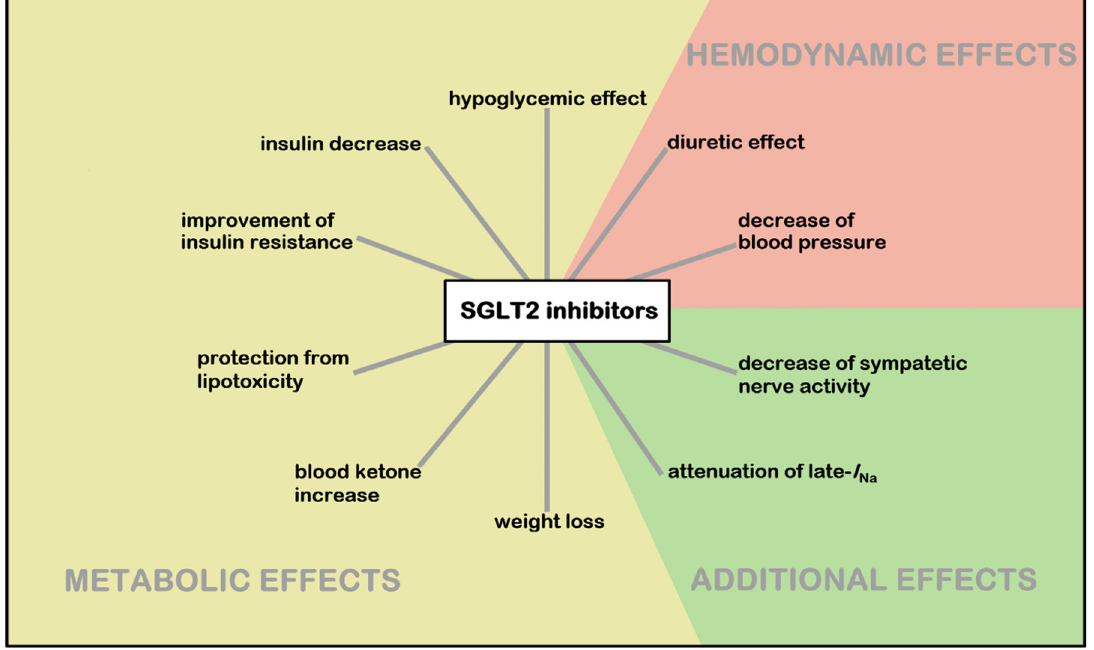
Figure 3. Potential SGLT2 inhibitor benefits in heart failure [67].